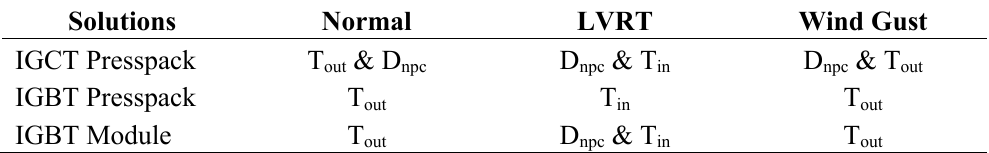
Table 4. Most stressed devices for different power device solutions.